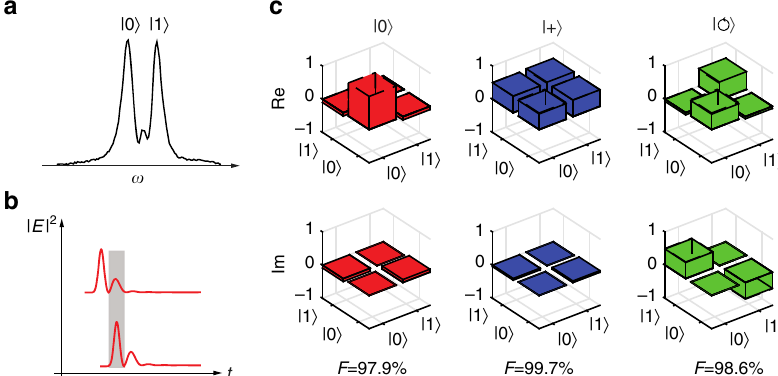
Figure 4 | Broadband qubit transfer with protected Nd ensembles. ( a ) Two polaritons serve as eigenbasis for a frequency bin qubit. A phase chirp can be added to construct a generic qubit 0 j iþ e i f 1 j i . ( b ) Simulated time-domain evolution of the cavity field intensities of two qubit-encoded photons, showing temporal overlap between the retrieved photon c 1 j ið Þ and the second photon ( c 2 j ið Þ ) directly transmitted through the cavity at time t R . The fields dominantly overlap within a temporal window (grey area) when interference occurs yielding integrated photon counts proportional to the overlap c 2 c 1 jh ij j . The overlap after the grey window was negligibly small due to fast cavity decays. ( c ) Reconstructed density matrices for each input qubit (top row) delayed by t R showing high